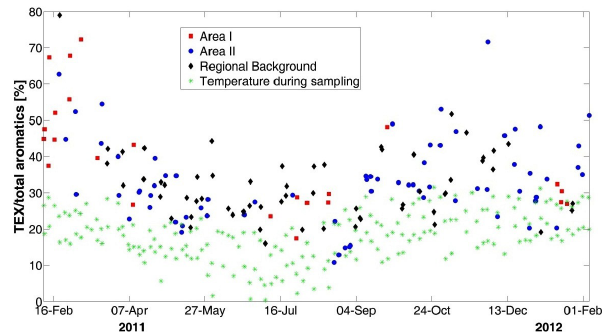
Figure 8. Temporal variation in the concentration ratios of the sum of toluene, ethylbenzene and xylenes (TEX) to total aromatics from air masses arriving at Welgegund after passing over the three source